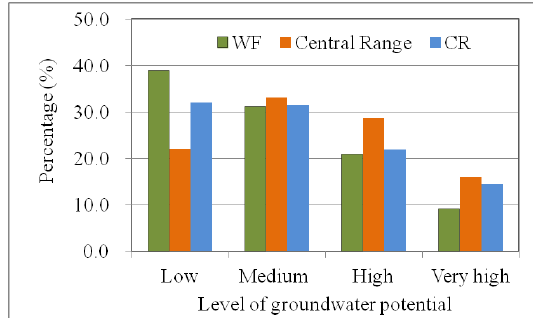
Figure 11. The percentages of WF, the Central Range, and CR in low to very high levels of groundwater potential.